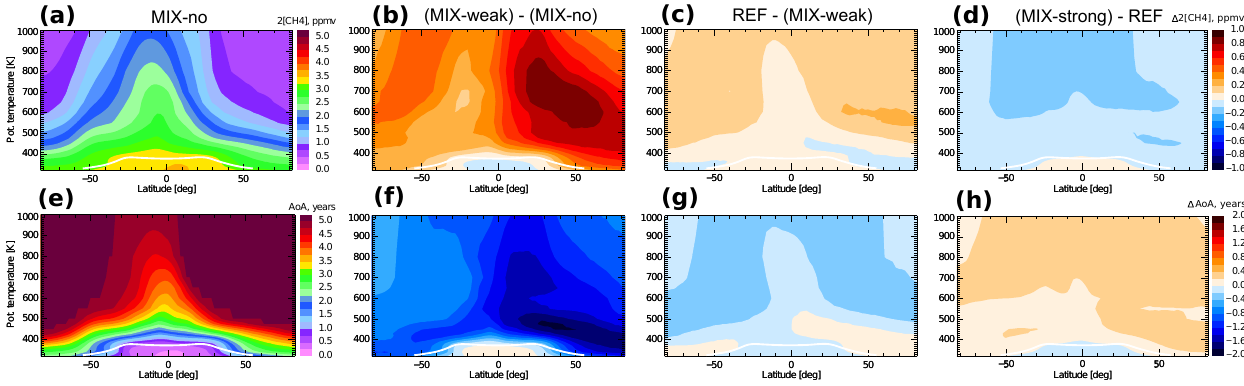
Figure 14. Annual zonal mean distributions of 2CH 4 (a) and mean age of air (b) from the CLaMS simulation without mixing (MIX-no), as well as the incremental differences between the sensitivity simulations with increasing mixing from the weak mixing case (MIX-weak) through the reference (REF) to the strong mixing case (MIX-strong), i.e. ((MIX-weak) – MIX-no) in the second column (b, f) , (REF – (MIX-weak)) in the third column (c, g) , and ((MIX-strong) – REF) in the fourth column (d, h) . Tropopause is represented by a white solid line and is calculated from ERA-Interim reanalysis data. The data are shown for